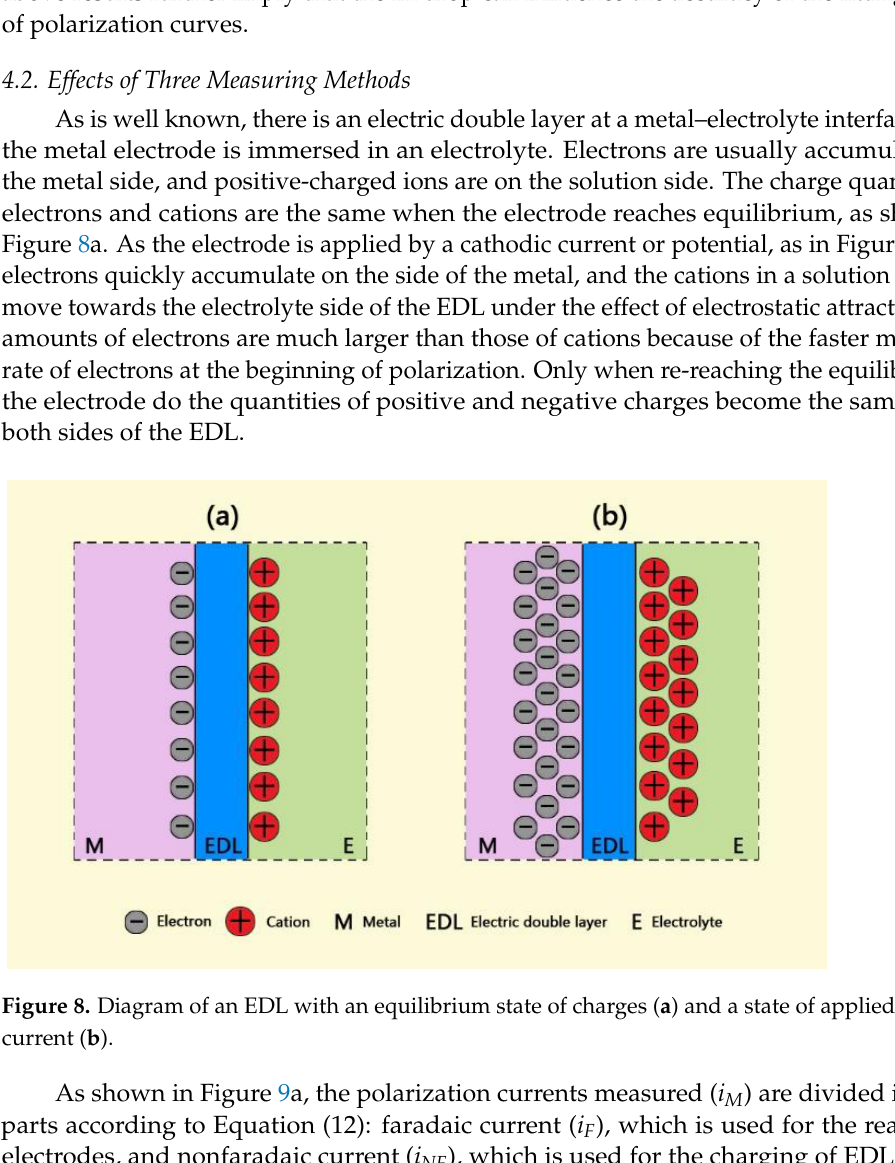
Table 8. Balance time of E OCP for M2 after finishing the measurement of the cathodic curve. HCl